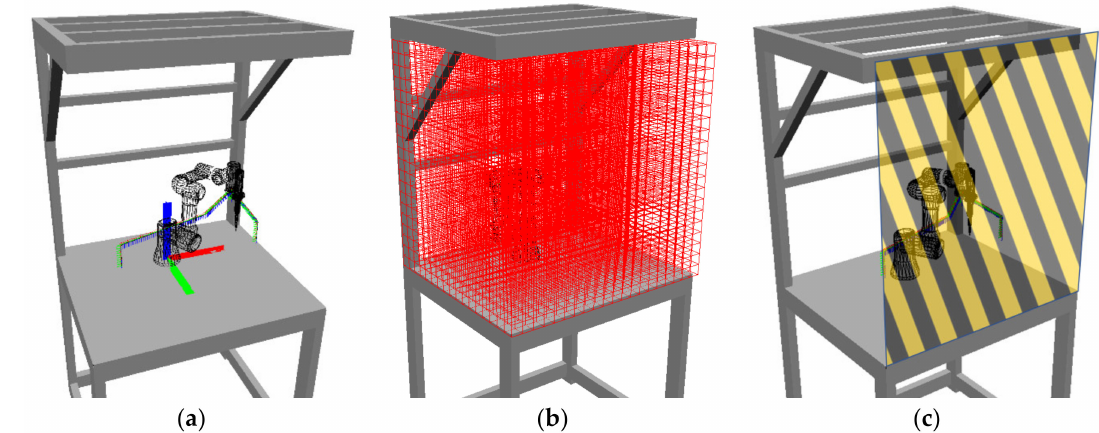
Figure 12. Simulation of the experimental workplace: ( a ) robot trajectory between stations A, B, and C; ( b )voxelgridcoveringtheworkspacevolume(voxelsizeis5cm); ( c